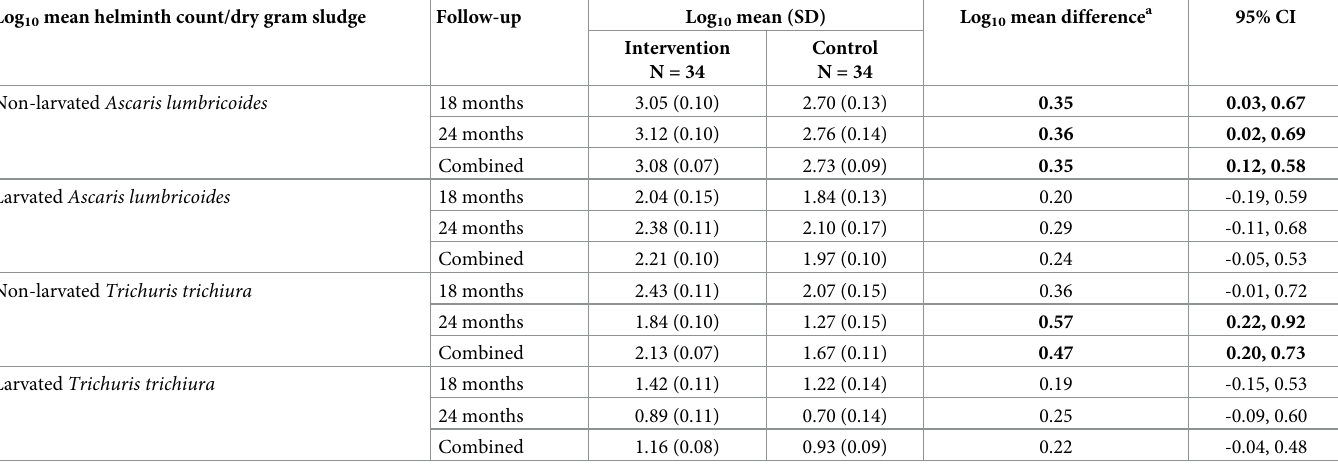
larvated T . trichiura , and 1.16 for larvated T . trichiura (Table 3). The log STH ova count per dry gram of sludge in latrines without sand barriers was 2.73 for non-lar- vated A . lumbricoides , 1.97 for larvated A . lumbricoides , 1.67 for non-larvated T . trichiura , and 0.93 for larvated T . trichiura (Table 3). Compared to latrines without sand barriers, latrines with sand barriers had significantly higher count of non-larvated A . lumbricoides ova (log mean difference: 0.35, 95% CI: 0.12, 0.58) and non-larvated T . trichiura ova (log ence: 0.47, 95% CI: 0.20, 0.73) (Table 3). There were no statistically significant differences in larvated ova counts between the two types of latrines for A . lumbricoides and T . trichiura (Table 3). Both the non-larvated and larvated T . trichiura counts declined by more than 50% between the 18-month and 24-month follow-up (Table 3). Table 3. Mean log 10 helminth ova counts per dry gram of latrine sludge at 18 and 24 months of follow-up. Log 10 mean helminth count/dry gram